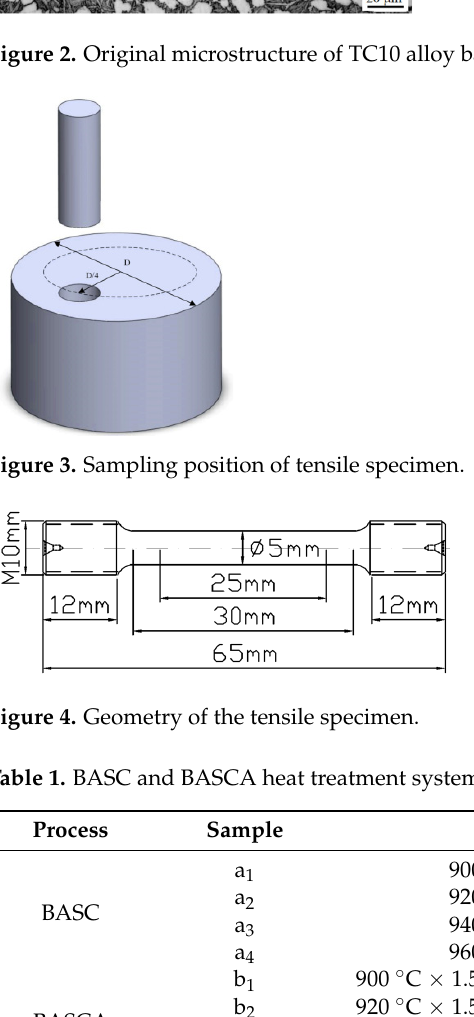
Figure 4. Geometry of the tensile specimen. Table 1. BASC and BASCA heat treatment system.